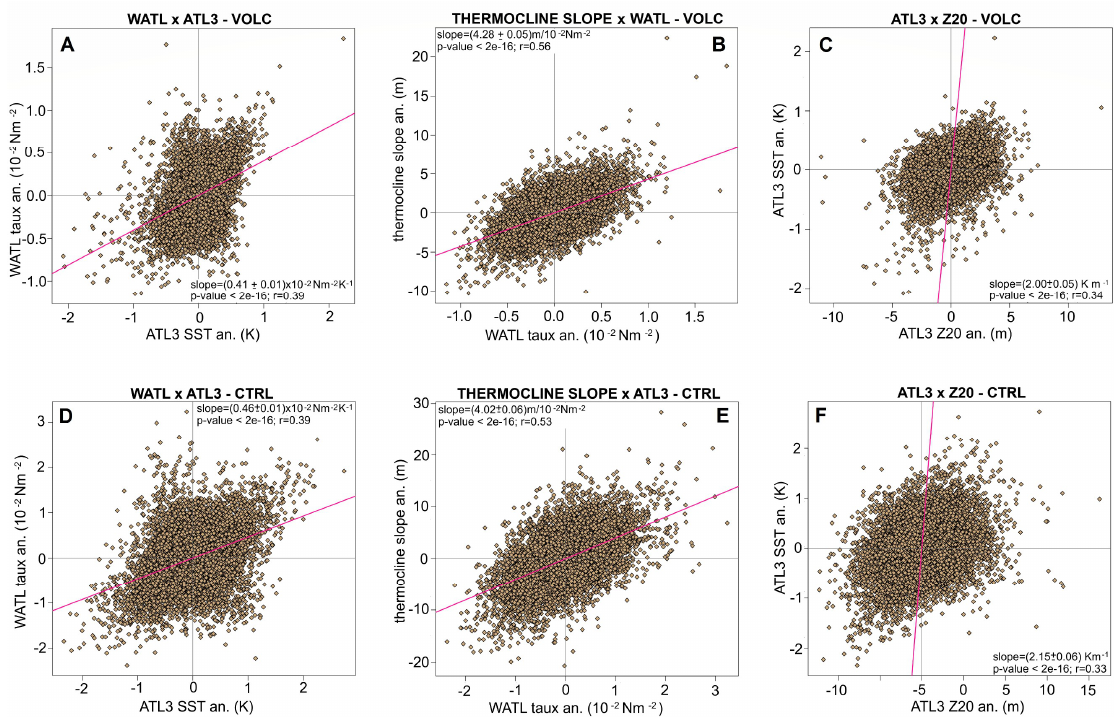
Figure 8. Tropical Atlantic air–sea interaction indicators for ( A – C ) VOLC and ( D – F ) CTRL simulations, represented by linear regressions of monthly values. First column refers to ATL3 SST and WATL zonal wind stress anomalies, second column refers to equatorial thermocline slope and WATL wind stress anomalies, and third column refers to ATL3 SST and ATL3 thermocline depth anomalies. Thermocline depth is defined as the 20 ◦ C-isotherm depth. Slopes and correlation were both calculated with 95% significance. The calculated regression slopes are also displayed in Table 2. Table 2. Air–sea interaction processes slopes in the Tropical Atlantic, calculated as in references [4,48].